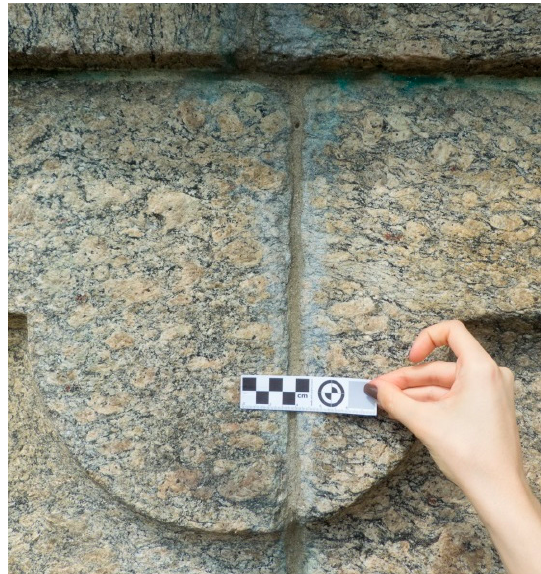
Figure 11. Light staining area on a Gneiss block.